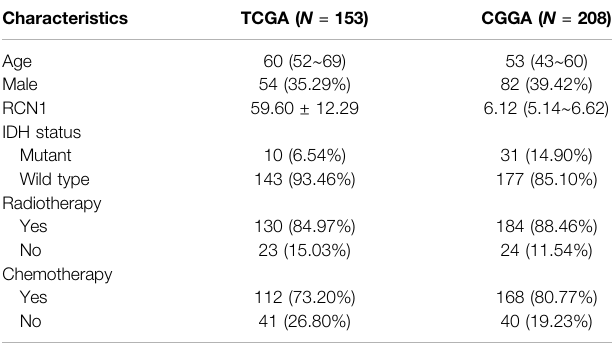
TABLE1| TheclinicalcharacteristicsofpatientsandexpressionofRCN1inGBM.